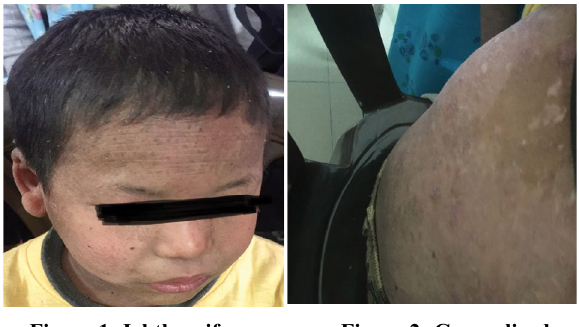
Figure 1: Ichthyosiform